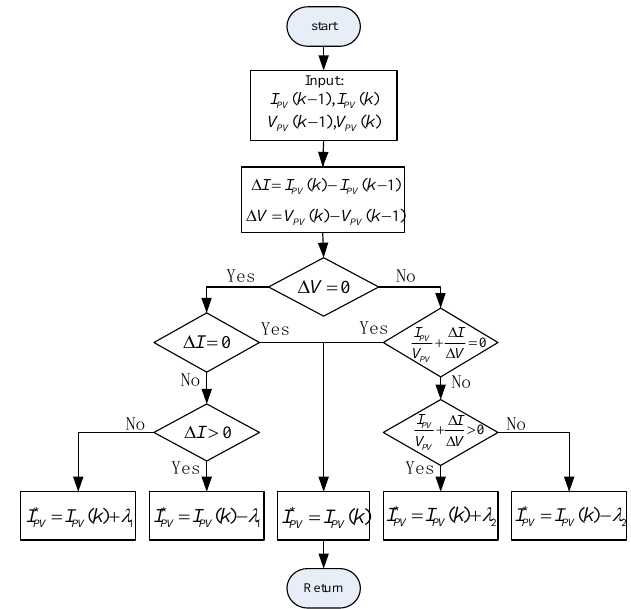
Figure 3. Flowchart to determine reference current by dual step I&C algorithm.